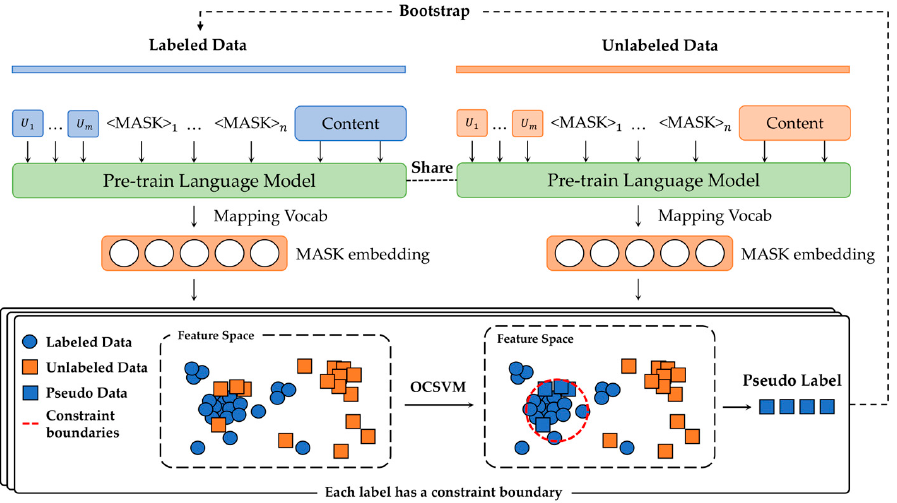
Figure 2. The strategy of adding unlabeled data and performing iterative training is implemented through the One-Class Support Vector Machine-based Unlabeled Data Leveraging